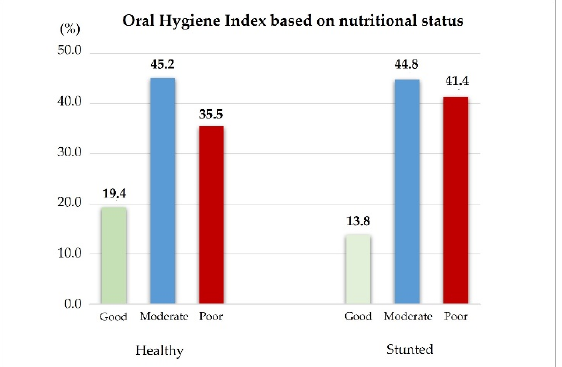
Figure 1. Percentage of oral hygiene group based on nutritional status.